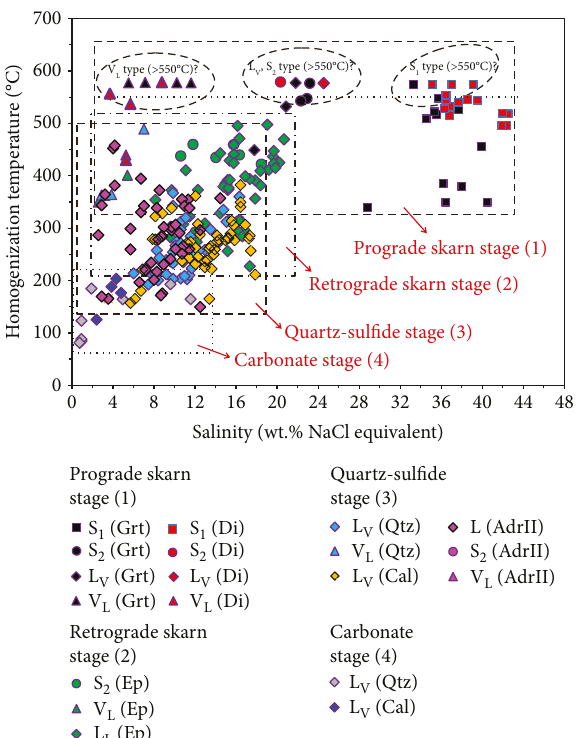
Figure 11: Plot of homogenization temperature (Th) versus salinity for fl uid inclusions in di ff erent host minerals and stages, showing characteristics of fl uid evolution in the Fuzishan Cu-Mo deposit. Note that the dotted ellipses representing fl uid inclusion inferred for greater than 550 ° C in the prograde skarn stage.